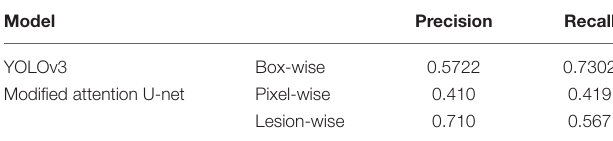
TABLE 1 | Skull fracture identification on the test